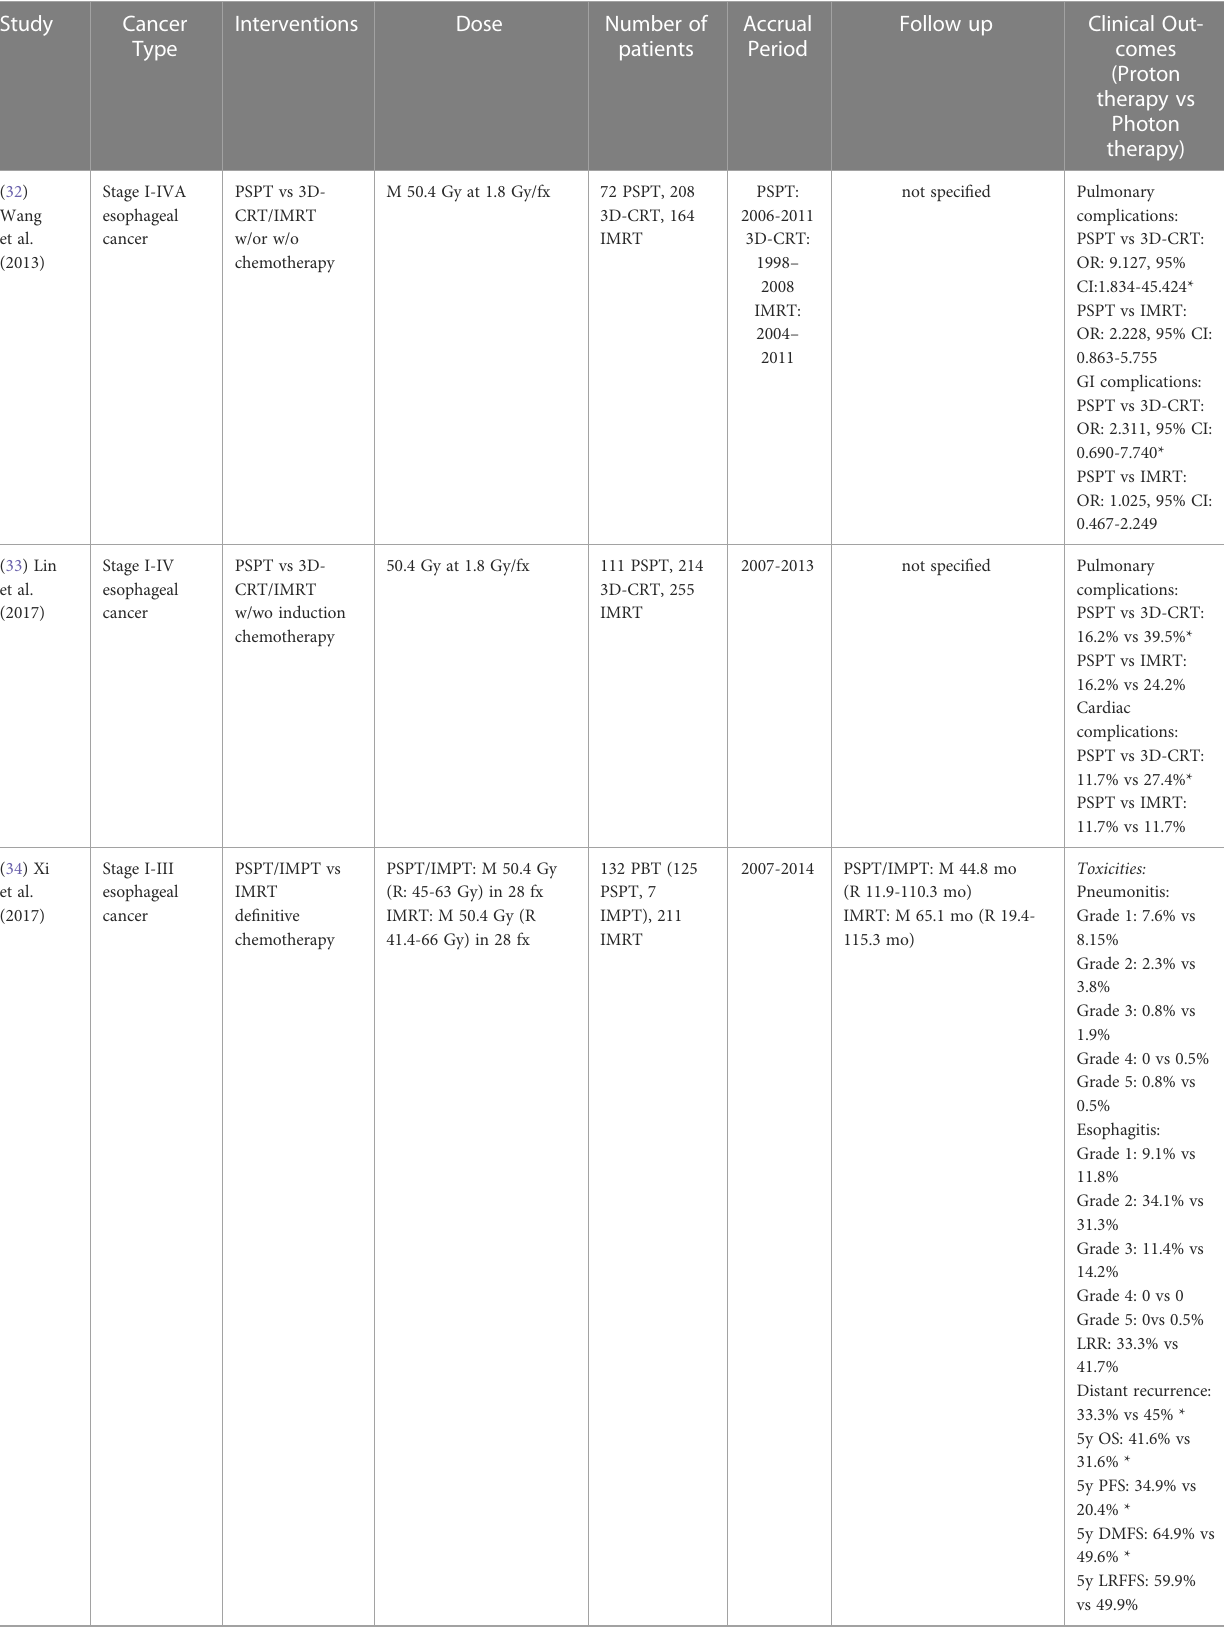
TABLE 4 Non-randomized clinical studies of proton versus photon radiation therapy - esophageal